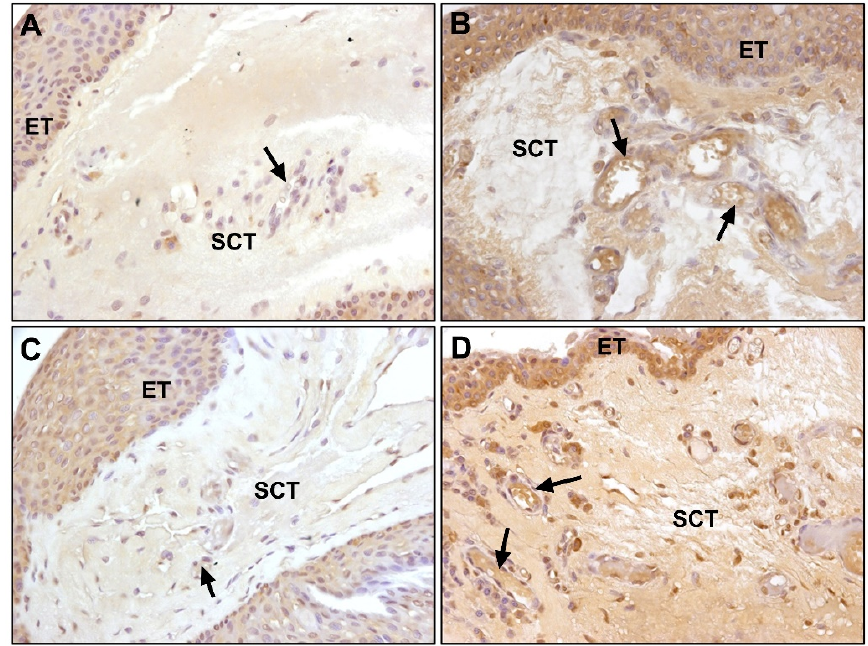
Figure 11. Immunohistochemical labeling for LOX in ( A ) conjunctival and ( B ) pterygium tissue (×400). LOXL1 expression in ( C ) conjunctival and ( D ) pterygium tissue (×400). LOX and LOXL1 can be observed in the subepithelial matrix in both samples, with a higher expression in pterygium. (ET, epithelial tissue; SCT, subepithelial connective tissue; → , blood vessels).